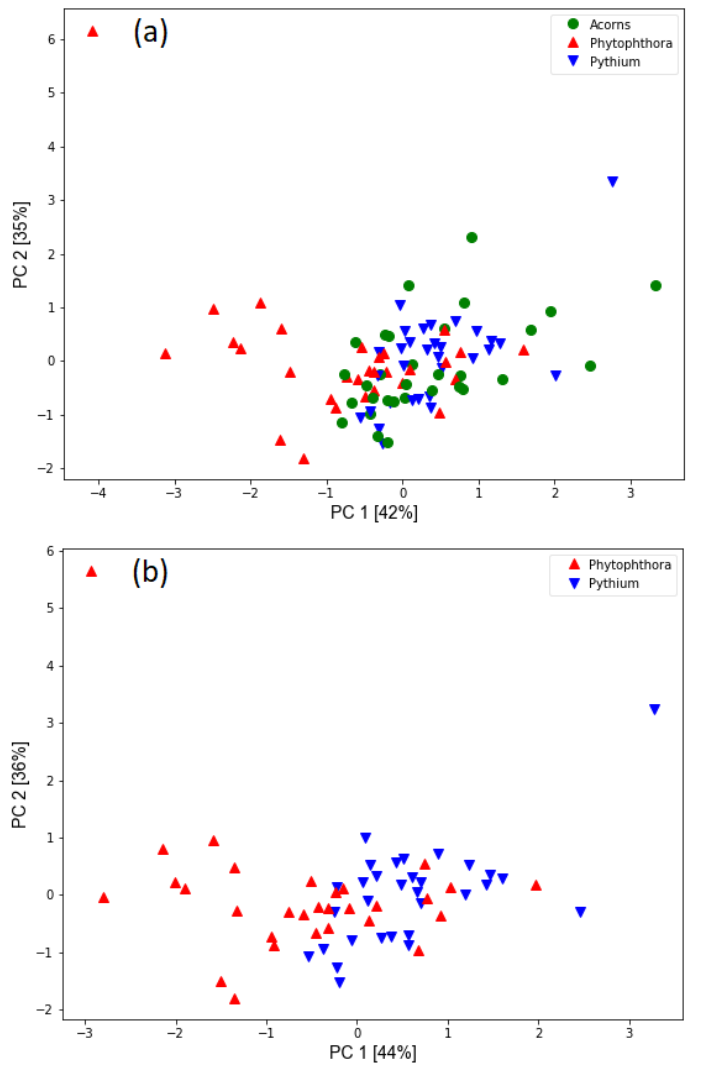
Figure 5. Distribution of measured samples based on principal component analysis transformation of modelling features extracted from sensor response curves. The percentage of variability accounted for by the principal components is indicated in the axis labels. The types of samples measured are represented with different colours and symbols. ( a ) The three categories of measured samples are plotted. ( b ) Only the samples infected with oomycetes are shown to illustrate the